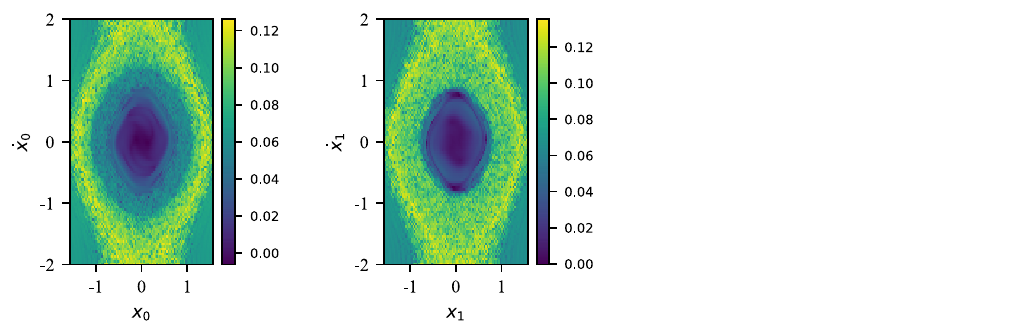
Figure 16. FTLE for the double